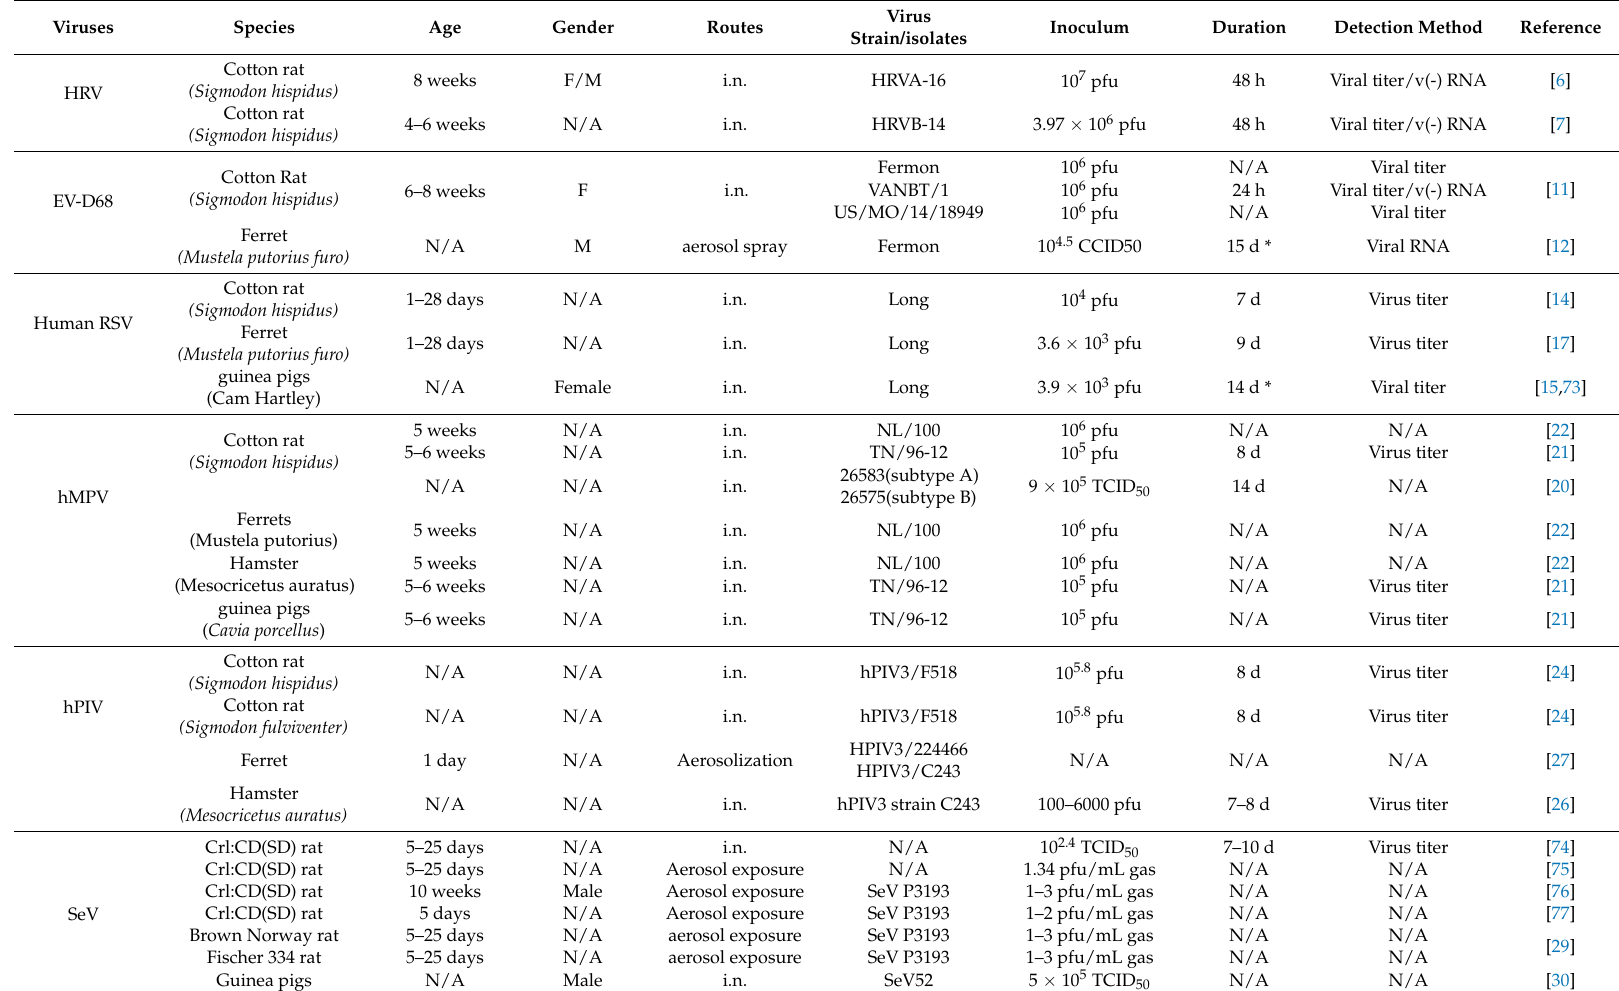
Table 3. Other small animal models of respiratory viral